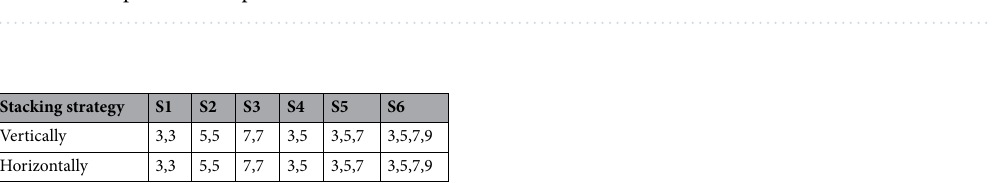
Table 5. Comparison with previous works.